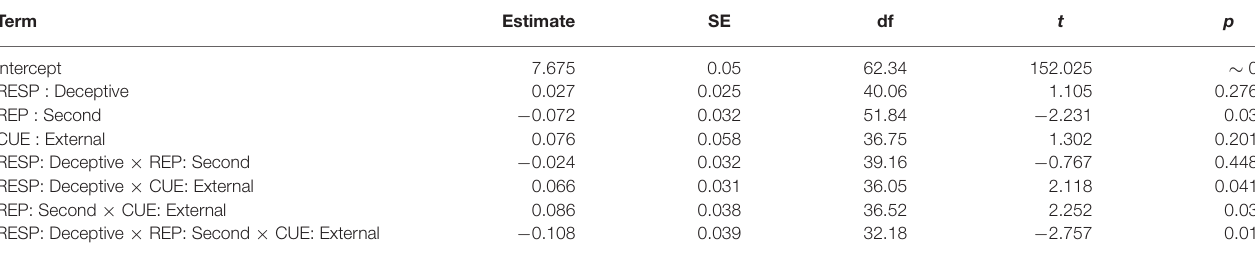
TABLE 2 | Linear mixed model coefficients (non-standardized), standard errors (SE), degrees of freedom (df), t -statistic value of a test comparing the parameter estimate to null distribution (t) and the p -value testing significance of the difference from 0 (p). Term Estimate